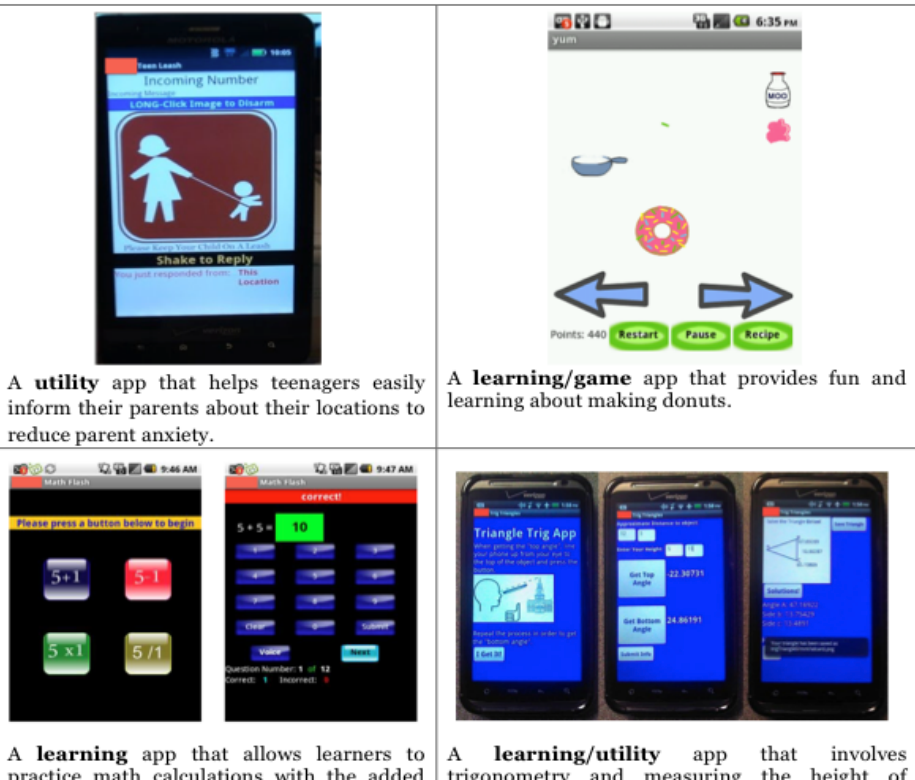
Figure 4. Various types of students’ project